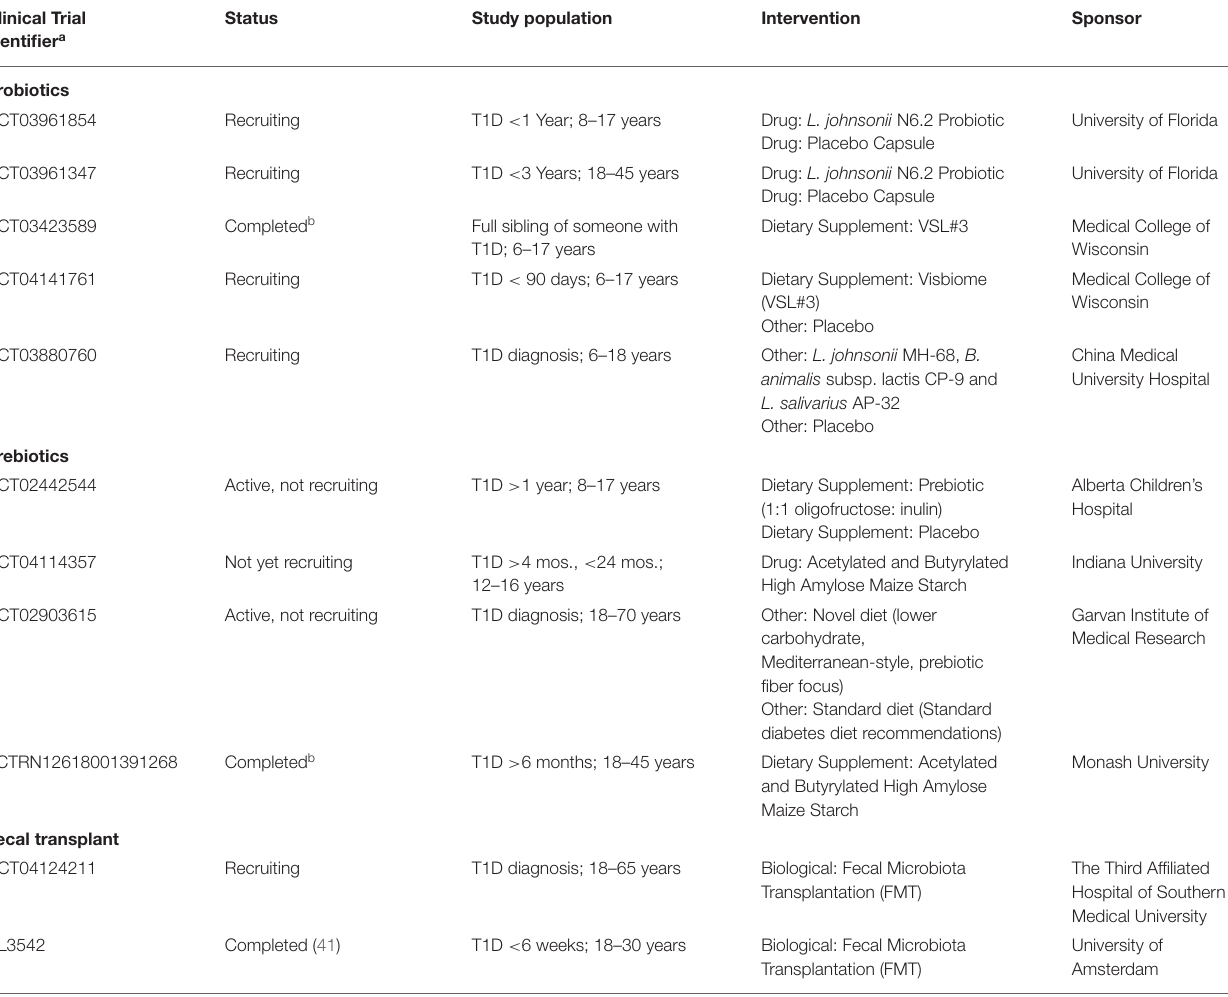
TABLE 1 | Clinical trials with completed or recruiting status with probiotic, prebiotics, and FMT interventions for T1D prevention or therapy. Clinical Trial identifier